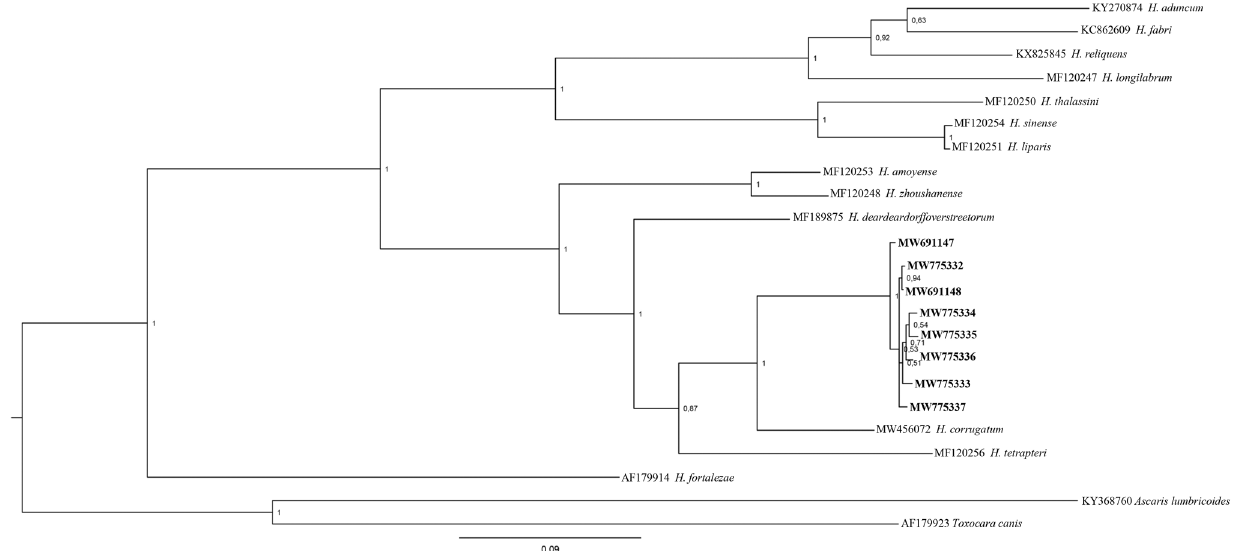
Figure 3. Phylogenetic tree from Bayesian inference on cox 2 sequences of Lappetascaris sp. obtained in the present study, with respect to the sequences of raphidascaridid species at the same gene loci available in GenBank. The analysis was performed by MrBayes, v. 3.2.7, using the TrN + I + G substitution model, as implemented in jModeltest 2.1.10. Ascaris lumbricoides and Toxocara canis were used as outgroup. Sequences obtained in the present study are in bold. Tree was drawn using FigTree v. 1.3.1 (http:// tree. bio. ed. ac. uk/ softw are/ figtr